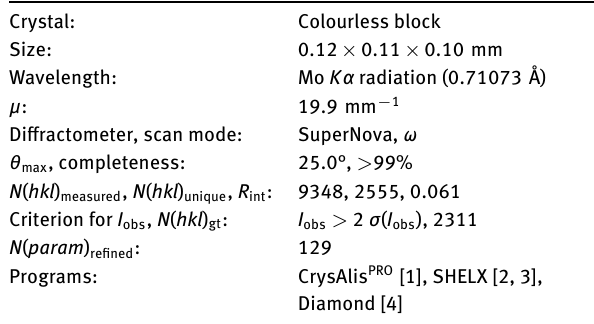
Table 2: Fractional atomic coordinates and isotropic or equivalent isotropic displacement parameters (Å 2